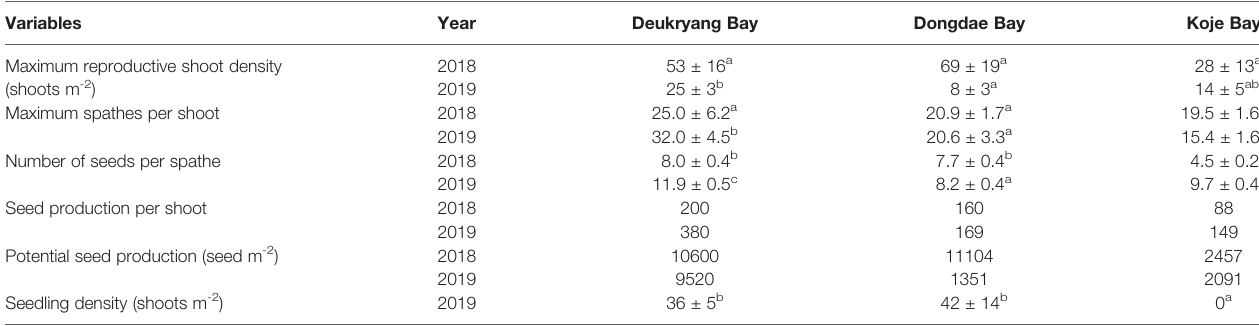
TABLE 3 | Zostera marina . Mean values of maximum reproductive shoot density, maximum spathes per shoot, number of seeds per spathe, seed production per shoot, and potential seed production during 2018 and 2019, and seedling density during January 2019 in Deukryang Bay, Dongdae Bay, and Koje Bay on the southern coast of